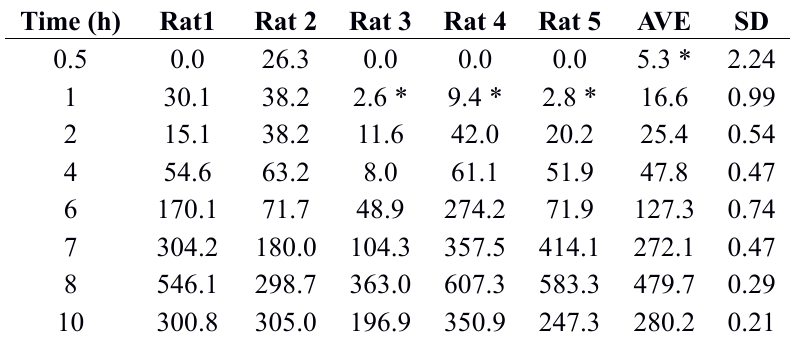
Table 15. Concentration time of TA-III after intragastrical administration to rats at a dose of 75 mg/kg